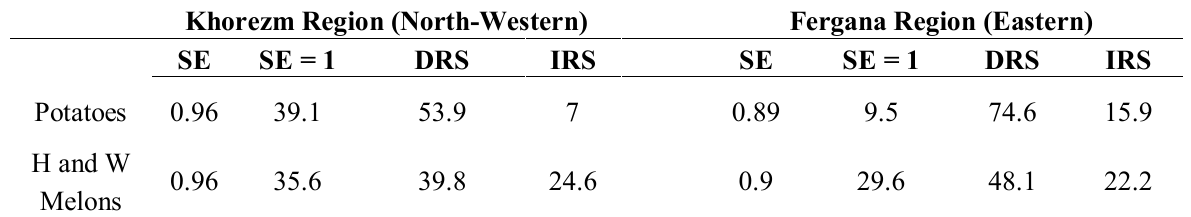
Table 3. Scale efficiency estimates (% of